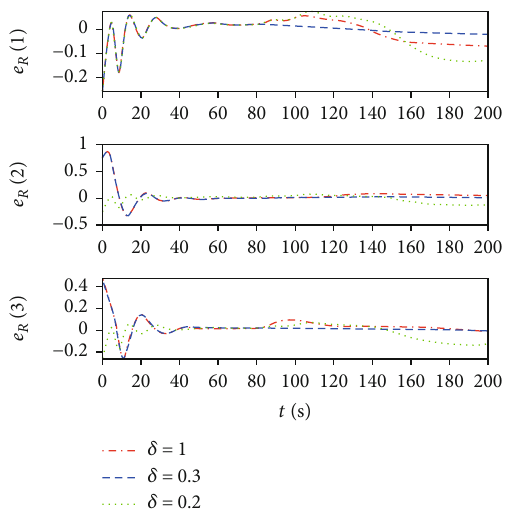
Figure 1: Attitude tracking errors under di ff erent δ .